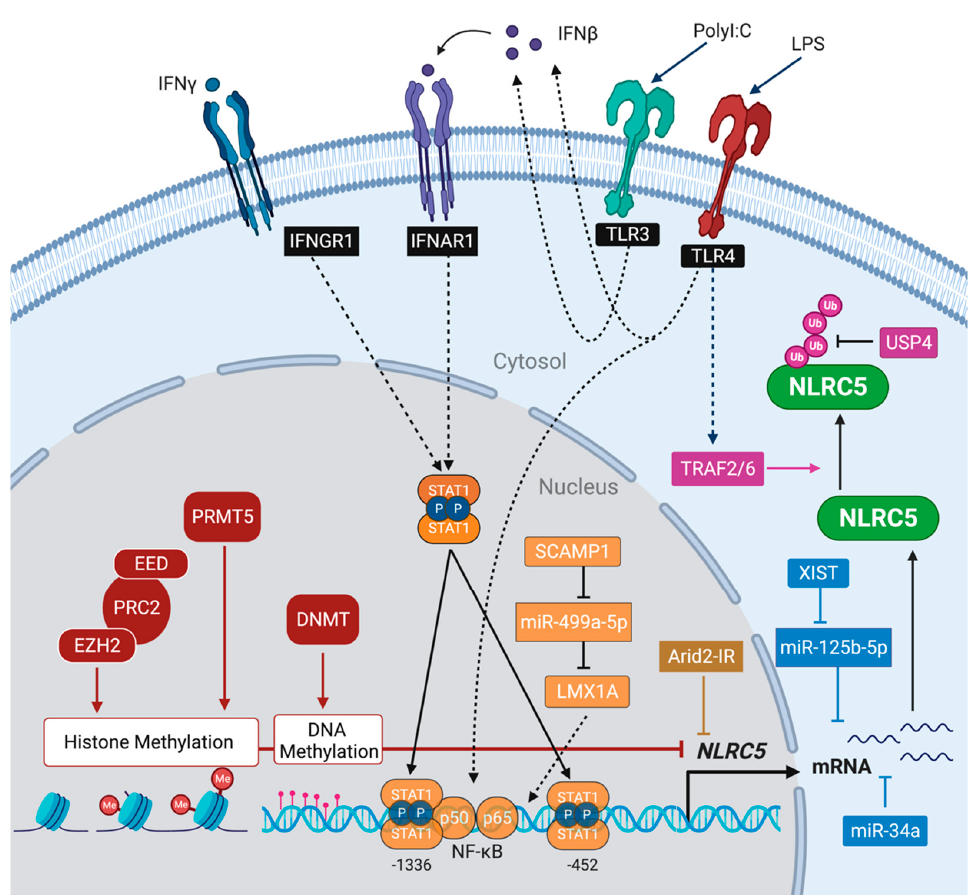
Figure 3. Regulation of NLRC5 gene expression. IFN γ strongly induces NLRC5 gene expression through transcriptional activation of STAT1. STAT1 homodimers bind the GAS sequences in the NLRC5 promoter (-452, -1336). Type-I IFNs, induced by TLR ligands also induce NLRC5 via STAT1 activation. NF- κ B activation by TLRs can synergize with STAT dimers by binding to the distal GAS site. NLRC5 is regulated by (i) epigenetic modifications of its promoter as well as at the (ii) transcriptional, (iii) post transcriptional and (iv) post-translational levels as detailed below: ( i, factors indicated in burgundy color ) Epigenetic regulation. NLRC5 promoter may be repressed by DNA methylation by DNA methyl transferases (DNMT), histone lysine methylation by the polycomb repressive complex 2 (PRC2) (containing lysine methyltransferase EZH2 [Enhancer of Zeste Homolog 2] and EED [Embryonic Ectoderm Development]) or histone lysine methylation by protein arginine methyltransferase 5 (PRMT5). ( ii, orange ) Transcriptional activators (STAT1 and NF- κ B) and their modulators. The LncRNA Arid2-IR (AT-rich interactive domain 2-intronic region) binds to the NLRC5 promoter and prevents its transcription. The lncRNA SCAMP1 (Secretory carrier-associated membrane protein 1) modulates NLRC5 transcription by removing miRNA miR499-5p, thereby relieving its repressive effect on LMX1A (LIM homeobox transcription factor 1) that binds to multiple sites at the NLRC5 promoter. ( iii, brown, blue ) Post-transcriptional regulation by miRNAs. miR-34a and miR-125b-5p downregulate NLRC5 expression by destabilizing mRNA and inhibiting translation. miR-125b-5p is regulated by the lncRNA XIST. ( iv, purple ) Post-translation regulation. NLRC5 is ubiquitinated by the TRAF2/6 complex induced by TLR signaling. Ubiquitin-specific protease 14 (USP14) deubiquitinates